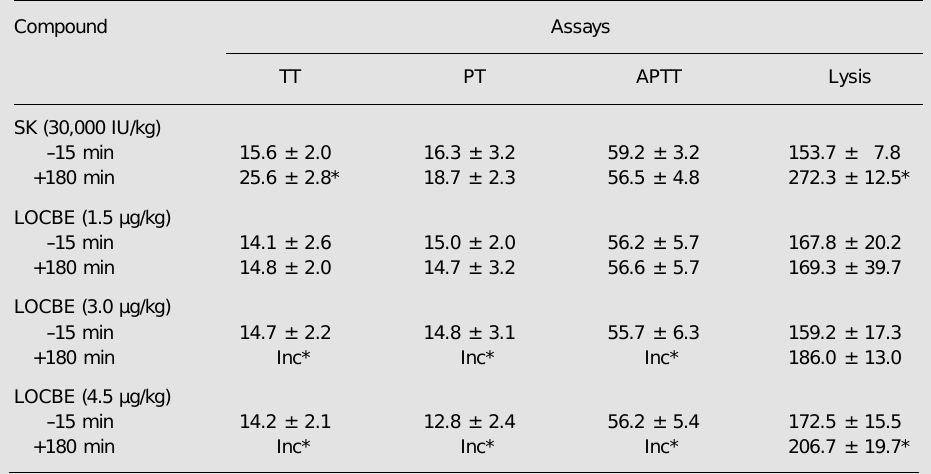
Table 4. Effects of streptokinase and Lonomia obliqua caterpillar bristle extract (LOCBE) infusion on the coagulation parameters of rabbits.